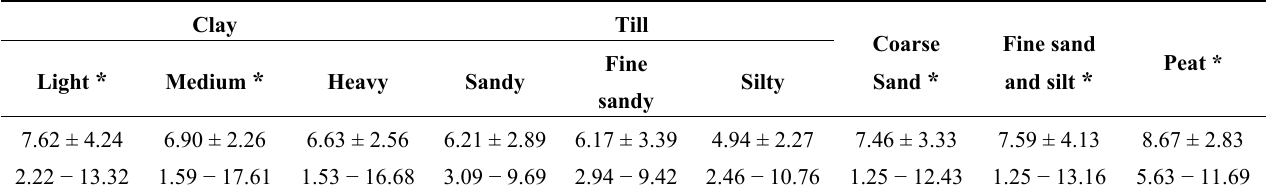
Table 4. Mean annual increment, m 3 ha − 1 year − 1 for Norway spruce ( Picea abies (L.) Karst.) stands growing on farmland with different soil